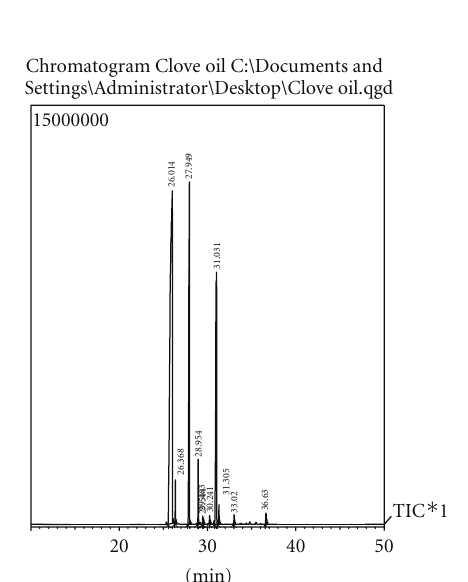
Figure 1: Chromatogram of clove essential oil showing represen- tative peaks of eluted components. Peak at 26.014 min corresponds to presence of eugenol and peak at 31.031 min to eugenyl acetate. X -axis represents retention time (RT), and the Y -axis shows the intensity (abundance) of the signal.